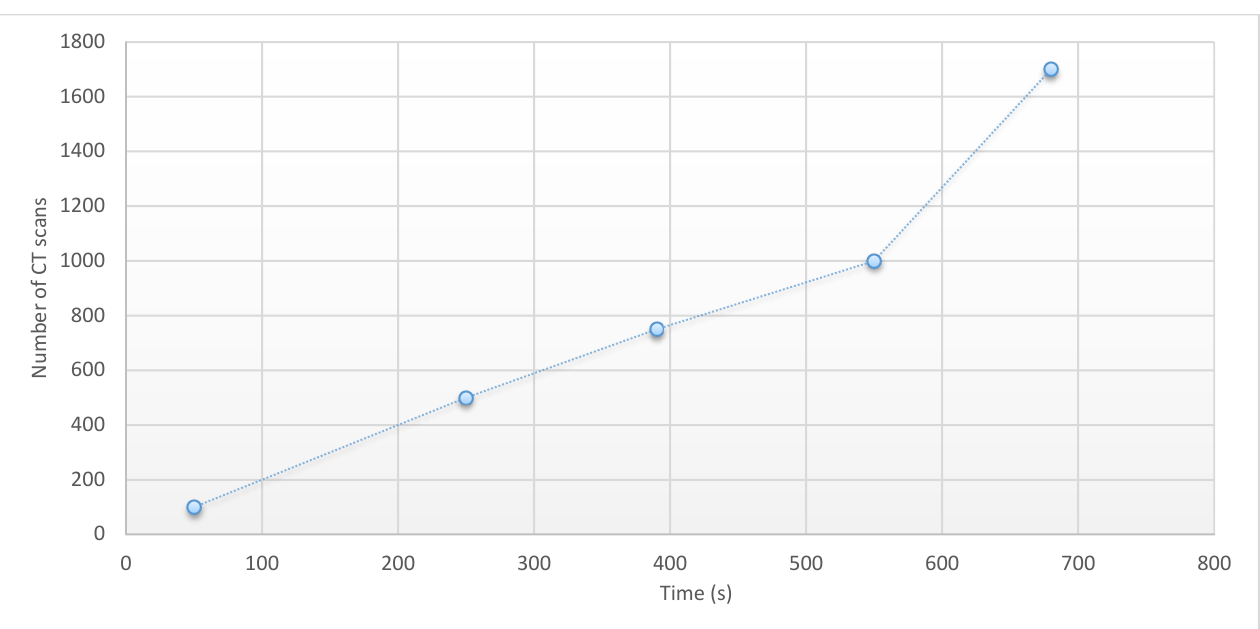
Table 3. Impact of using densely connected convolutions and BConvLSTM on system performance. Method